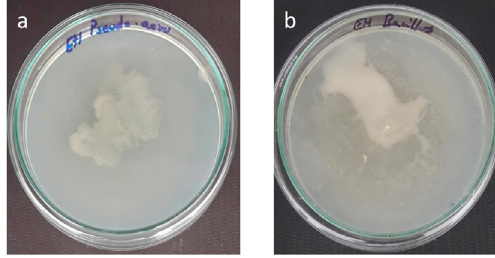
Fig. 8. Swarming motility of crude silver nanoparticle against a) Pseudomonas aeruginosa b) Bacillus